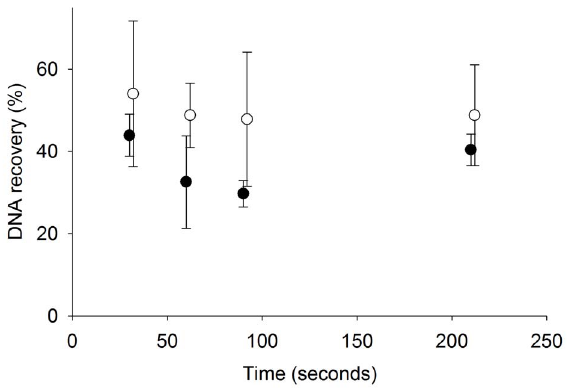
Figure 8. There was no significant change in DNA recovery with increased adsorption (white circles) or elution (black circles) times (mean 6 s.d., n=3). In each experiment, the adsorption time was held at 30 s while the elution time was varied (black circles), and the elution time was held at 30 s while the adsorption time was varied (white circles). To more clearly illustrate the error bars on each data point, the adsorption data was plotted two seconds to the right at each time